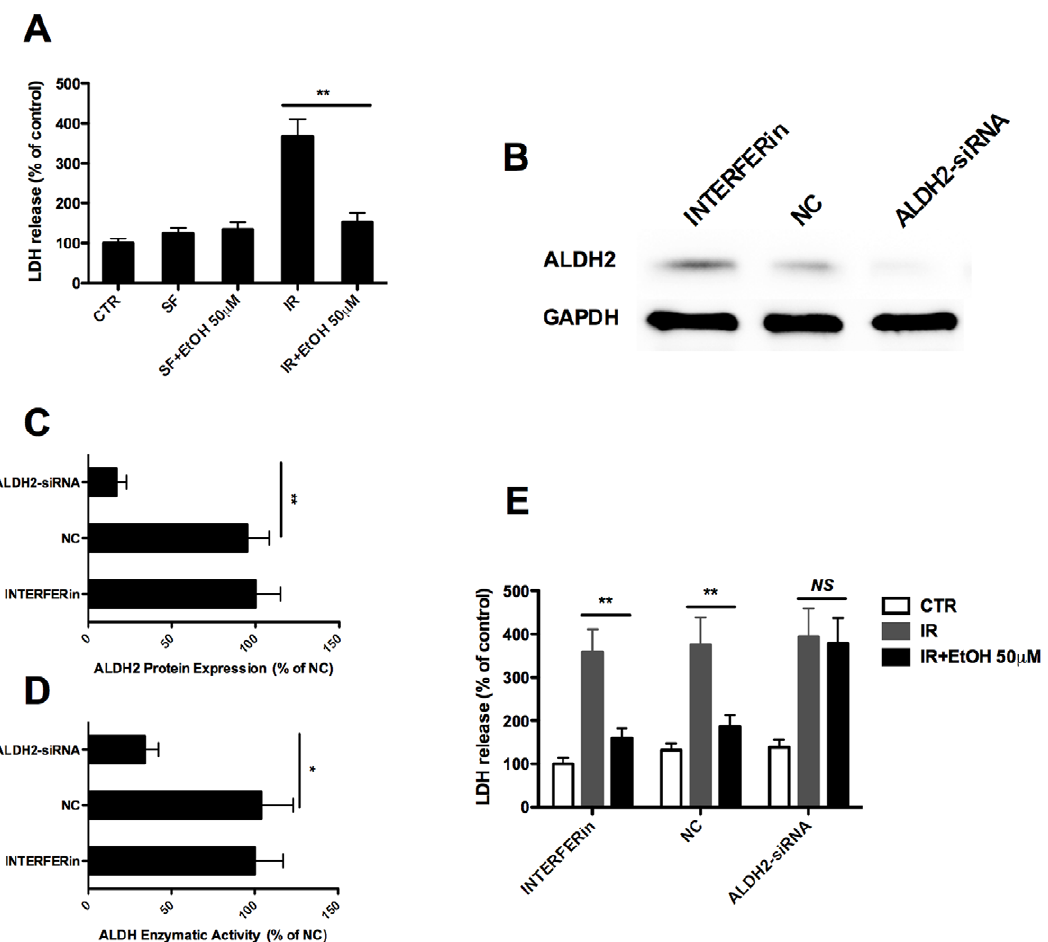
Figure 7. The protection induced by ethanol pretreatment is ALDH2 dependent. A. Primary cultured TECs were starved in serum-free (SF) medium for 24 h. Simulated IR were induced by immersing cell monolayer in mineral oil for 60 min at 37 u C, then incubated in full medium for another 24 h and assayed the LDH release. Ethanol pretreatment were given at 3 h before ischemia at a dose of 50 m M. B. and C. Primary cultured TECs were transfected with negative control siRNA (NC) or ALDH2-siRNA using INTERFERin TM transfection reagent. The INTERFERin group served as the empty control. ALDH2 protein contents were assayed by western blot at 48 h post transfection. D. Cells were treated as in B , and ALDH enzymatic activities were assessed at 48 h post transfection. E. Cells were treated as in B , and then induced simulated IR as in A at 48 h post transfection. LDH release was assayed at 24 h post transfection. Results are mean values 6 SEM. ( n =4–6). (* p , 0.05, ** p , 0.01).